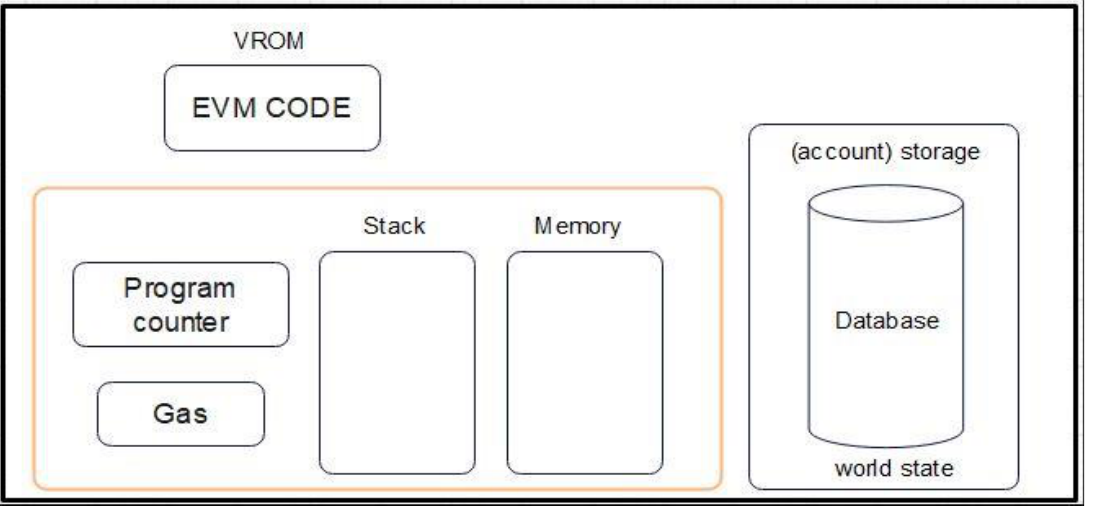
Figure 1. EVM ’ s description. Figure 1. EVM’s description. The ownerless configuration aims to maximize uptime and security while limiting subterfuge